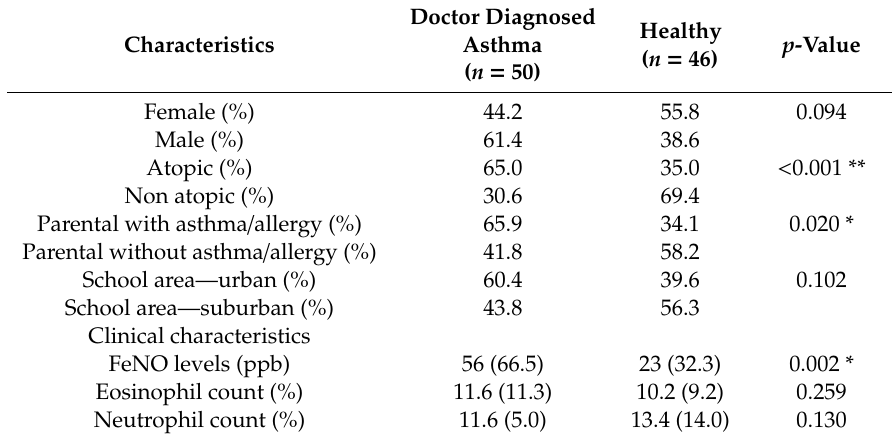
Table 1. Students’ characteristic and inflammation status for the doctor-diagnosed asthma and control group.